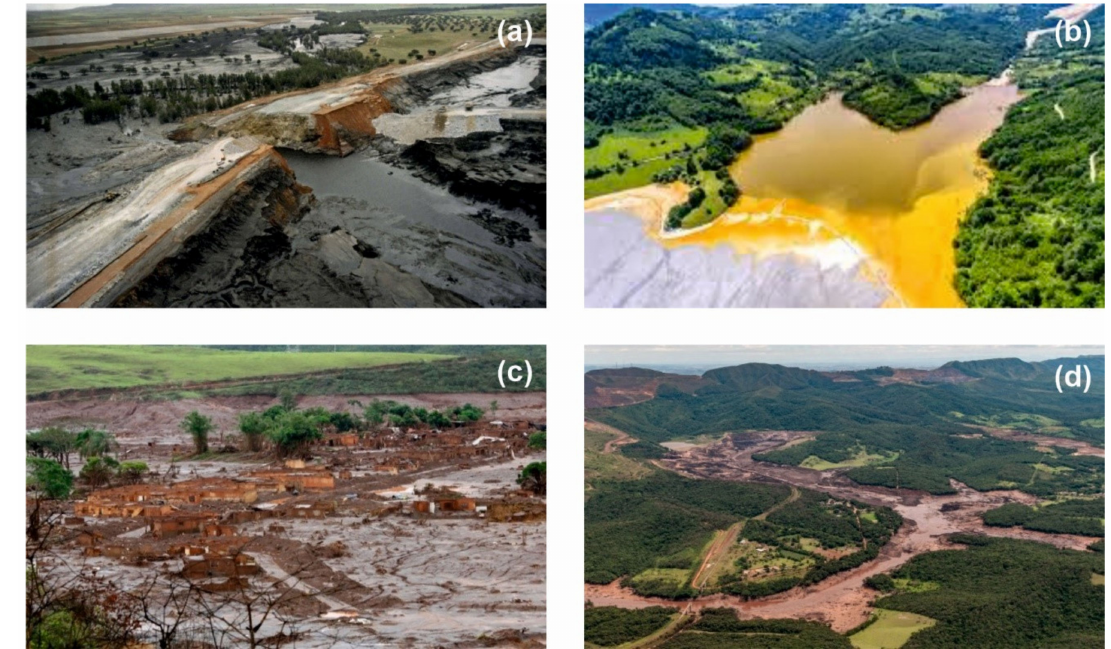
Figure 3. Images of several environmental disasters produced by collapse of tailing dams: ( a ) collapse of tailings dam in Azn á lcollar, Spain, 1998 [22]; ( b ) Baia Mare disaster, Romania, 2000 [23]; ( c ) Mariana dam disaster, Brazil, 2015 [24]; ( d ) Brumadinho dam disaster, Brazil, 2019